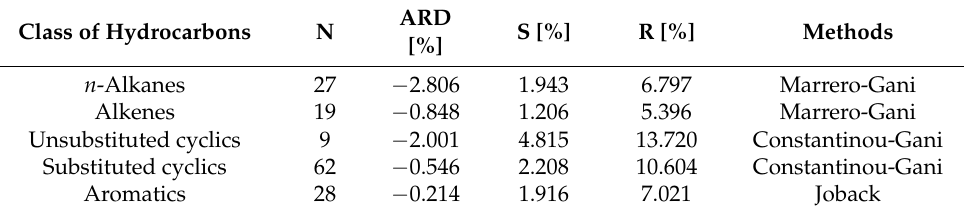
Table 5. Selected methods to predict the normal boiling temperature (T b ) of hydrocarbons classes ( n -alkanes, alkenes, unsubstituted cyclics, substituted cyclics, and aromatics), of all the compounds present in OLP, obtained by thermal catalytic cracking of palm oil at 450 °C, 1.0 atmosphere, with 10% (wt.) Na 2 CO 3 [17].